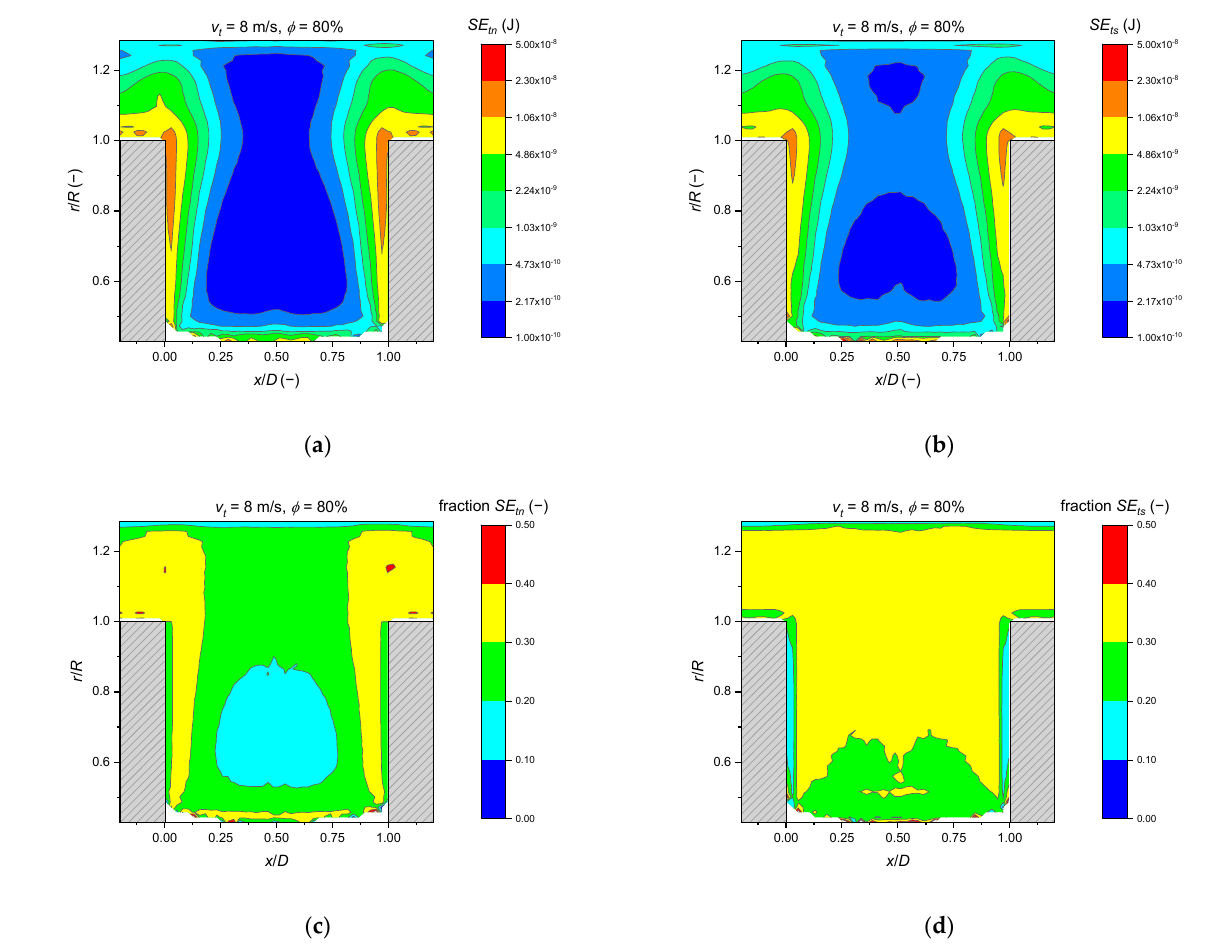
Figure 11. Radially averaged local stress energy components on a logarithmic color scale and their ratio in regard to the total stress energy of a collision: ( a ) stress energy SE tn resulting from the translatoric normal directional component of a collision; ( b ) stress energy SE ts resulting from translatoric shear components of collision; ( c ) ratio of SE tn per total stress energy SE of a collision; ( d ) ratio of SE ts per total stress energy SE of a collision.